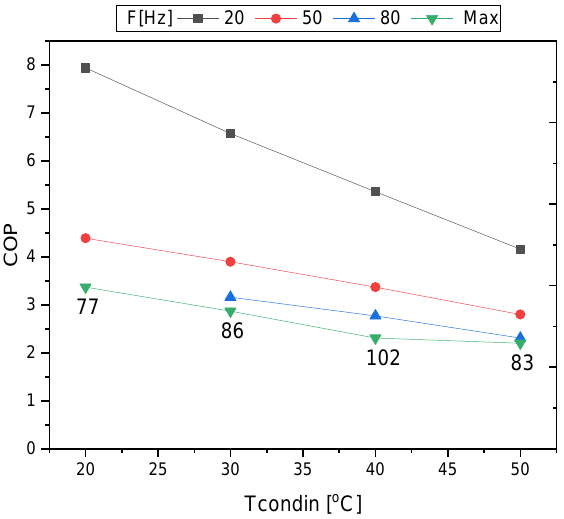
Figure 3. Coefficient of performance (COP) of the heat pump for various compressor speeds and condenser temperatures and an inlet air temperature of 21 °C. The curve “Max” shows the COP for the maximum allowed compressor speed for the specific boundary conditions, and the value of this maximum speed is given in Hz.